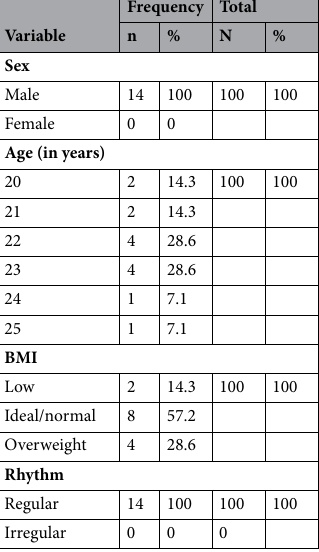
Table 1. Characteristics of subjects based on sex, age, body mass index and